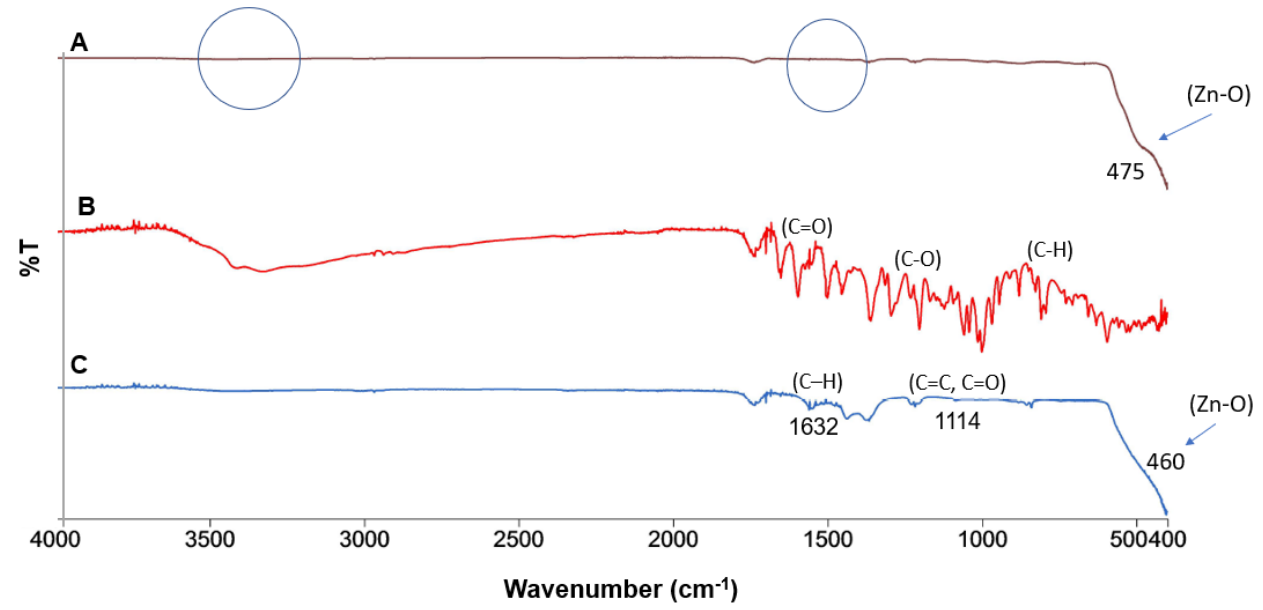
Figure 3. ATR – FTIR spectra of ( A ) ZnO Std NPs, ( B ) rutin and ( C ) ZnO-R NPs. Figure 3. ATR–FTIR spectra of ( A ) ZnO Std NPs, ( B ) rutin and ( C ) ZnO-R